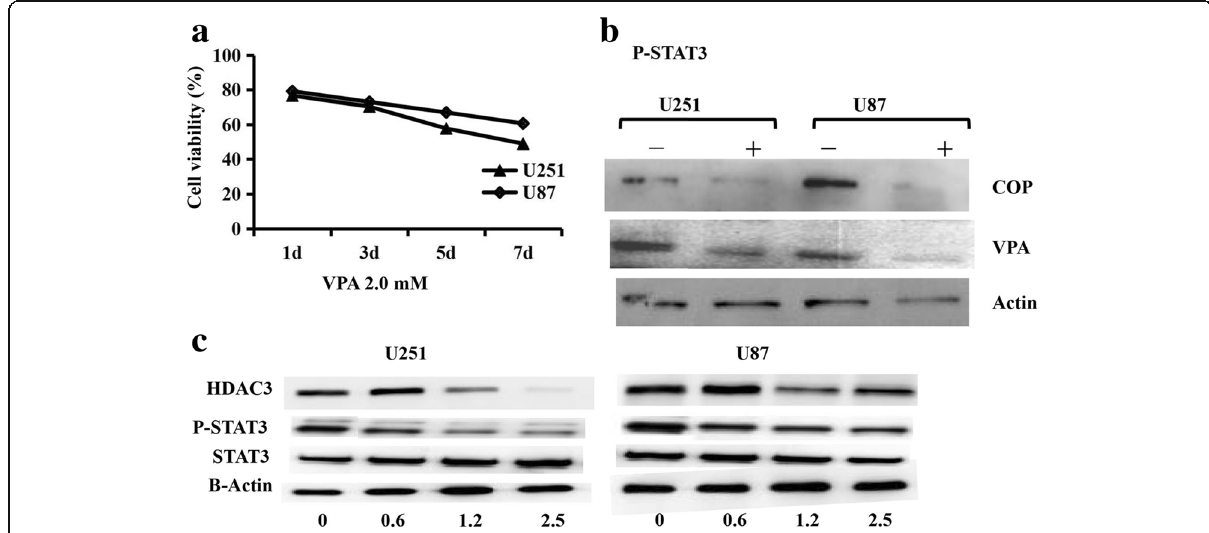
Fig. 8 COP induced protein expression in U251 and U87 cells. U251 and U87 ( a ) cells were treated with 2.0 mM VPA for 1, 3, 5 and 7 d, respectively, cell viability was analyzed by the MTT assay. b showed the VPA 2.0 mM and COP 5 mg/ml reduced the expression of STAT3 phosphorylation. c U251 and U87 cells were treated with COP for 24 h, the expression of HDAC3 and STAT3 phosphorvlation were